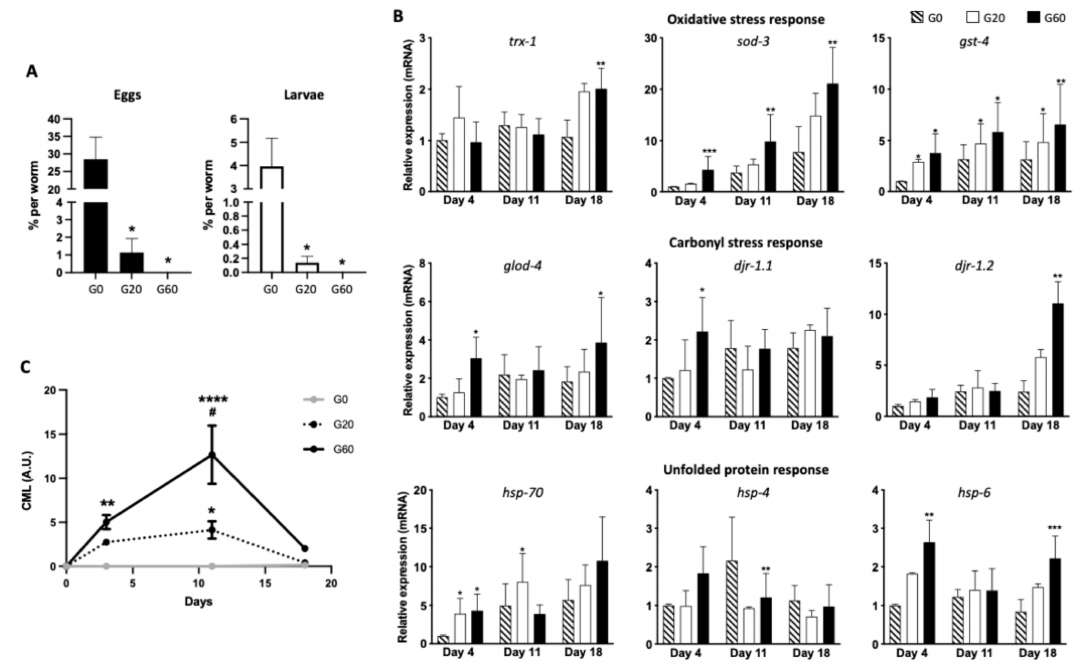
Figure 2. Effects of dietary N ε -carboxymethyllysine (dCML) exposure on worms’ progeny, transcriptional response to different stresses and levels of CML epitopes inside the worms. ( A ) Young adult worms were fed with bacteria, which were pretreated with 0 mM (G0), 20 mM (G20) or 60 mM (G60) of glyoxylic acid, in medium containing 5-fluoro-2 (cid:48) -deoxyuridine (FUdR). After 24 h of incubation, worms were grown for 2 days in the same conditions without FUdR. Number of eggs and larvae per worm present in the media were determined. Data were expressed as means ± standard deviation (SD) of 3 biological replicates. * p ≤ 0.05 G20 or G60 vs. G0 (Mann–Whitney test). ( B ) Young adult worms were fed for 4, 11 and 18 days with G0, G20 or G60 bacteria. Relative expression of gene coding for antioxidant, carbonyl stress and unfolded protein responses were analyzed by comparing all the conditions to the G0 at day 4. Data were expressed as means ± SD of three biological replicates. The cdc-42 and pmp-3 genes were used to normalize levels of gene expression. * p ≤ 0.05, ** p ≤ 0.01, *** p ≤ 0.001 G20 or G60 vs. G0 for the same incubation time (Kruskal–Wallis, Dunn’s multiple comparisons test). ( C ) Dot blots of lysates from worms fed 4, 11 and 18 days with G0, G20 or G60 bacteria were stained with anti-CML and anti-actin antibodies. CML and actin epitopes were quantified with ImageJ software and relative quantification of CML epitopes was normalized to actin. Data are expressed in arbitrary units (A.U.) and presented as the means ± SD of 3 biological replicates. * p ≤ 0.05, ** p ≤ 0.01, **** p ≤ 0.0001 G20 or G60 vs. G0, # p ≤ 0.05 G60 vs. G20 (2-way ANOVA, Tukey’s multiple comparisons